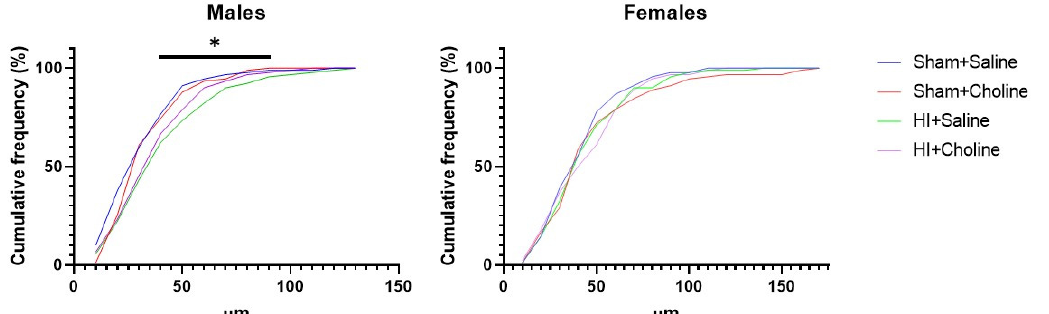
Figure 1. Choline supplementation restores neurite outgrowth in cerebellar granule cells derived from male pups subjected to HI. Cumulative frequency distributions of neurite lengths of cultured cerebellar granule cells. Neurite lengths were measured in neurons harvested from pups subjected to HI on PND10. Cells were fixed and stained for analysis 48 h after plating. Thirty cells per animal were quantified, from 3 animals per group for a total of 90 cells per group. Data are presented in 10 μ m bins. Kruskall Wallace ANOVA found a significant effect of group for male-derived cells, * = p < 0.008. HI reduced neurite length in male-derived cells only. Neurite lengths were shorter in the HI+saline group compared to the Sham+saline group, KS test, p < 0.009. Choline partially reversed this effect as HI + Choline derived cells did not differ from any other group, p > 0.05. No differences were detected in female-derived cells. HI = hypoxia ischemia.